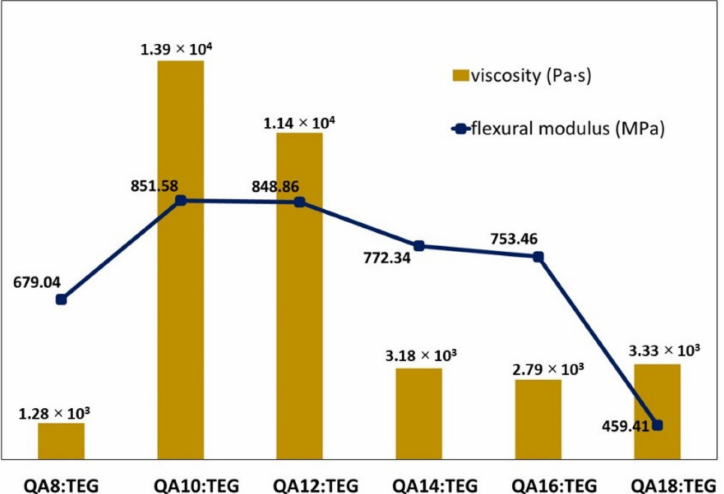
Figure 5. Flexural modulus of the QA:TEG copolymers and viscosity of the QAUDMA